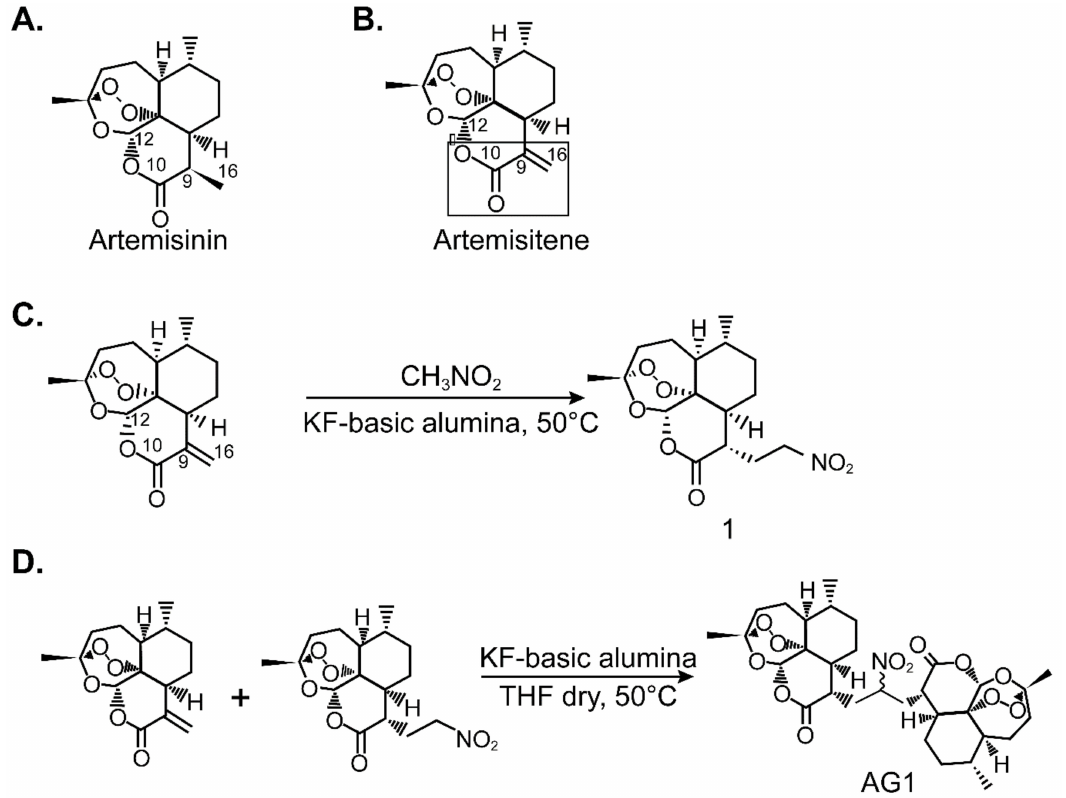
Figure 1. Synthesis of artemisinin-derived C-16 carba-dimer, AG-1. Nitroaliphatic chemistry was used to synthesize AG-1. ( A ) Artemisinin; ( B ) Artemisitene; ( C ) Scheme-1 for the synthesis of artemisinin-derived Michael adduct; (D) Scheme-2 for the artemisinin-derived C-16 carba-dimer,